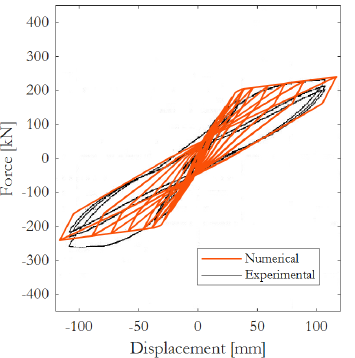
Figure 6. Comparison between numerical and experimental test results by Calvi and Bolognini [4].